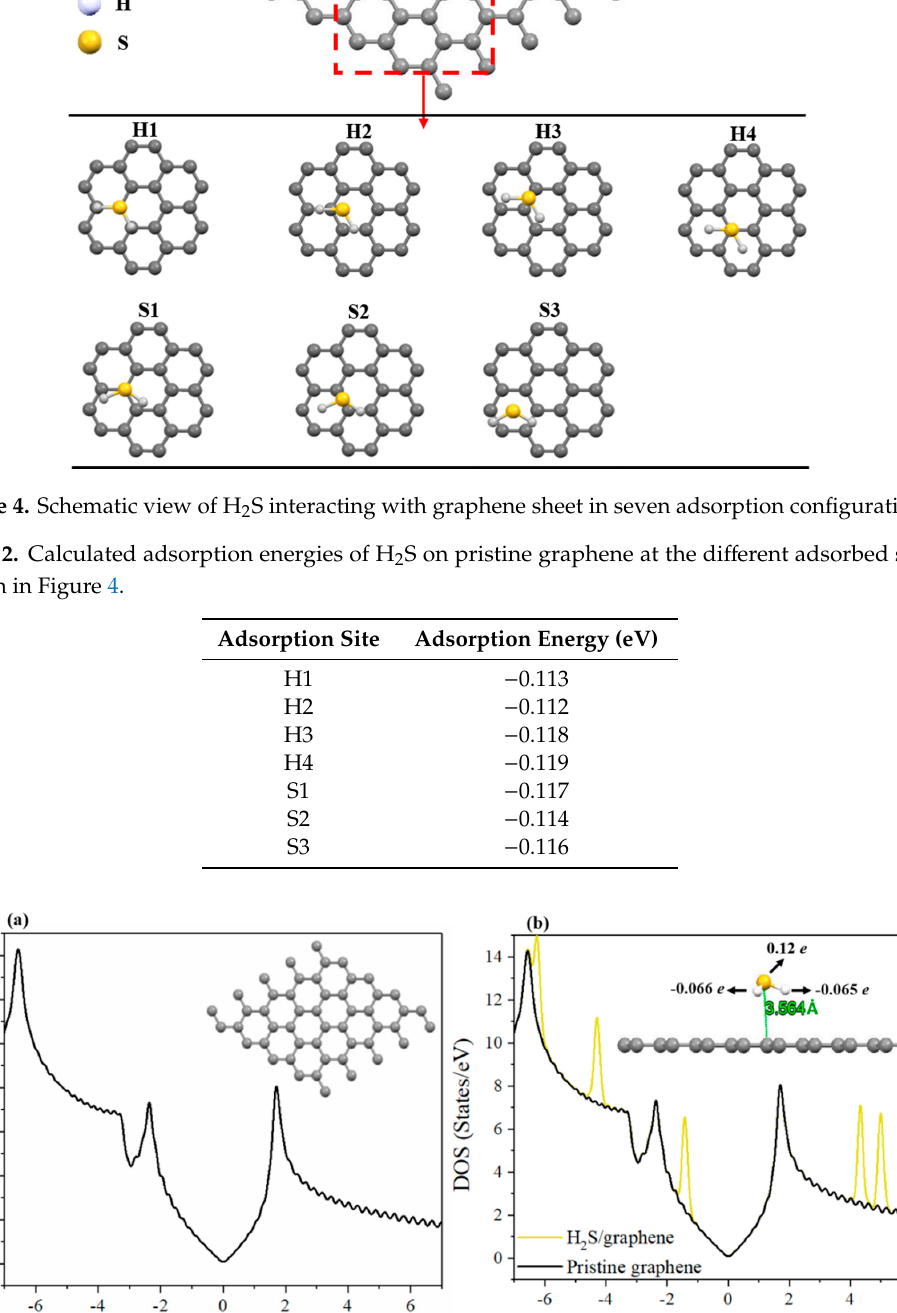
Figure 5. DOS plots for pristine graphene sheet: ( a ) before and ( b ) after adsorption of the H 2 S molecule at site H4 (the Fermi level is set to zero).